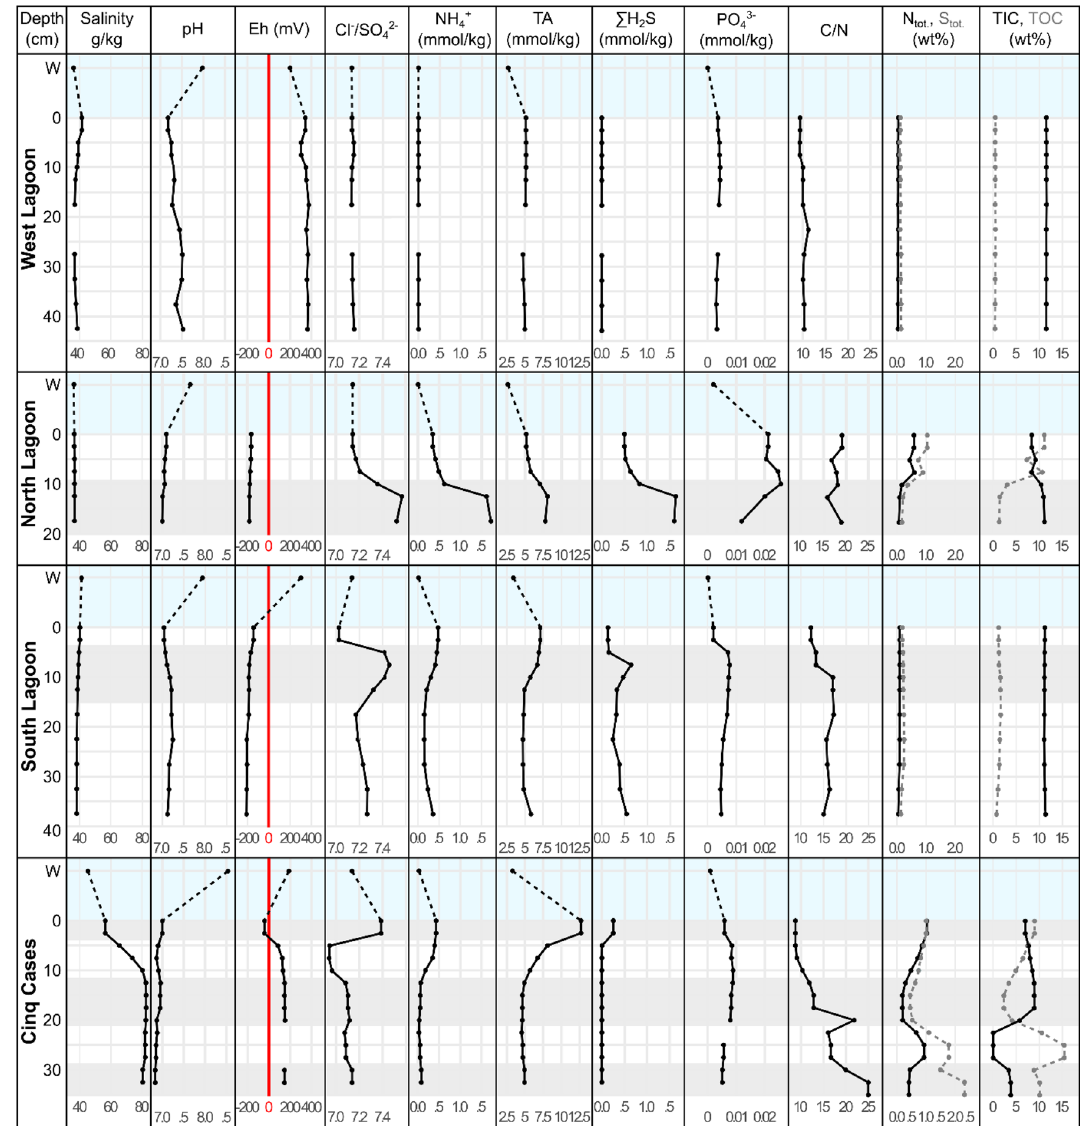
Figure 2. Selected porewater and bulk sediment geochemical profiles of the West Lagoon (WL), North (NL) and South (SL) Lagoon, and Cinq Cases (CC). Porewater profiles and sediment geochemistry were measured in two separate cores, except at Cinq Cases, where the same core was used. The water column (W) is set apart from the sediments by dashed lines and blue colour. Grey and white backgrounds indicate the geochemical zonation of the cores. The red line indicates the transition from reducing to oxidizing redox (Eh) conditions. Measurement accuracy deviated by less than underlying sediment consisted of light grey silt and showed a considerable decrease in concentration of the latter porewater components and an increasing SO 42− /Cl − ratio. The drop occurred alongside a significant increase in salinity ( P < 0.05) from 56 g/kg in the mat to 82 g/kg at 10 cm bsf (Fig. 2, Supplementary Tables S1 and S2). The Eh increased from reducing conditions (− 41 mV at 2 cm bsf) to increasingly oxidizing conditions, stabilizing at + 150 mV around 10 cm bsf. Below 10 cm of depth SO 42− /Cl − recovered to values around 0.141 and the other porewater components remained stable while ΣH 2 S was below detection limit. A further change in sediment stratification was observed as a high TOC layer between 22.5 and 27.5 cm bsf. TIC was almost completely absent in this layer, which had an ochre colour. Total N and S in the sediment matched the peak in TOC (Fig. 2). The C/N ratio increased significantly with depth (Fig. 2, Supplementary Fig. S1), culminating in a dark brown sedi- ment layer (Fig. 1e) rich in plant-based organic matter. Bacterial community composition and diversity in sediments of Aldabra. Sequencing of the V3-V4 region of 16S rRNA genes (total or DNA-based community) and transcripts (active or RNA-based com- munity) yielded a total of 8,473,178 (DNA) and 9,941,279 (RNA) high-quality reads. On average 79% of the reads passed bioinformatic processing and taxonomic assignment (Table 1, Supplementary Table S3). The final